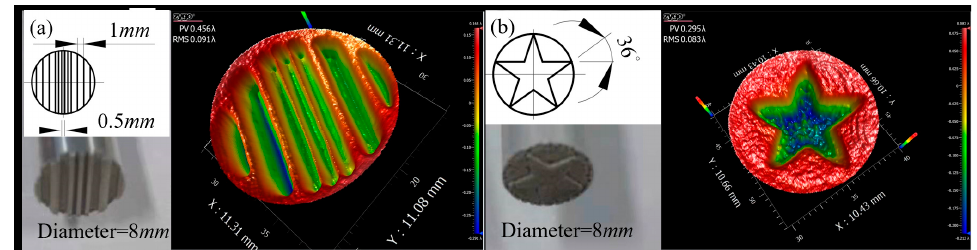
Figure 8. Material removal distribution formed using different geometric structures on the surface of ultrasonic vibration tools: ( a ) rectangle groove and ( b ) five − pointed star (time = 300 s, amplitude = 40 μ m, gap = 0.1 mm).